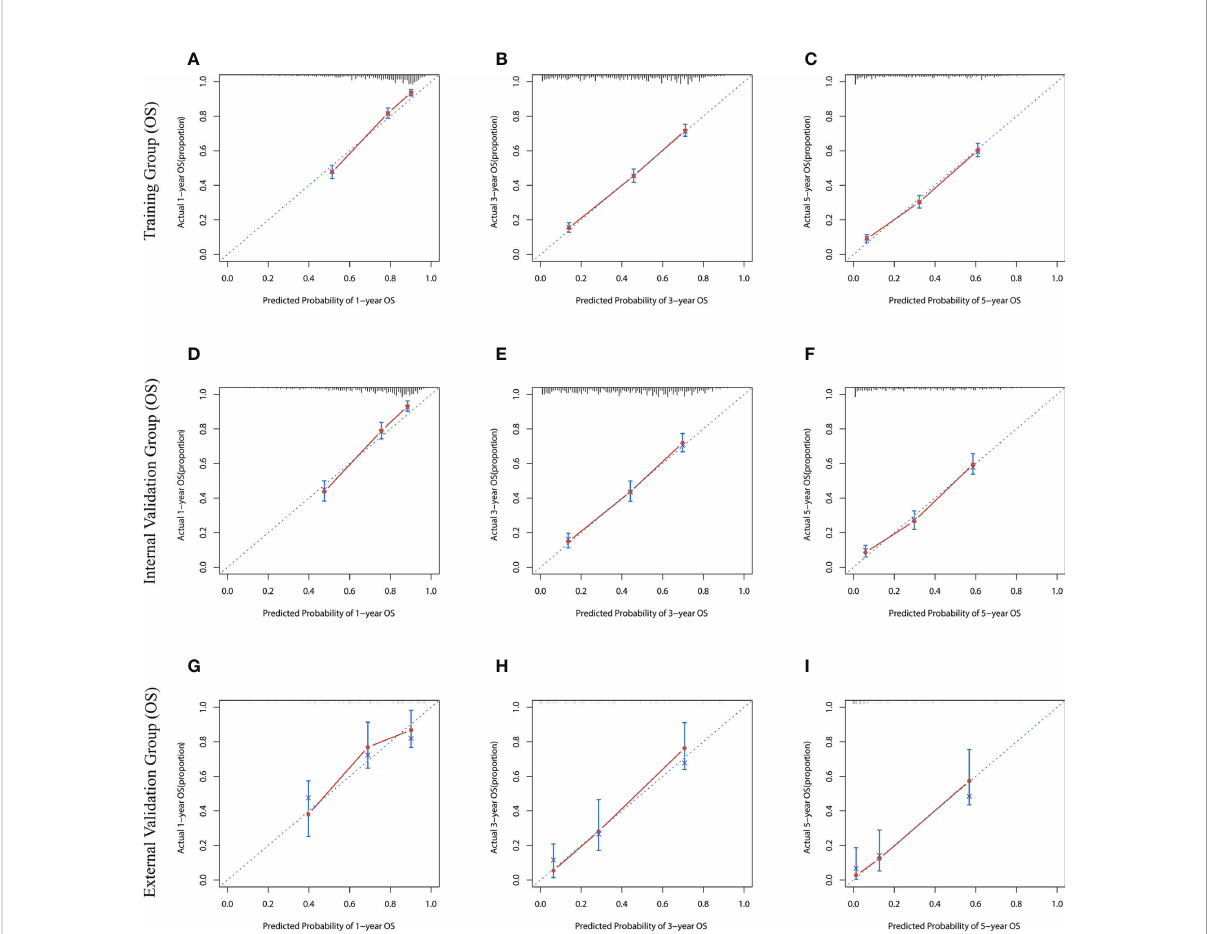
FIGURE 3 The calibration curves for predicting OS at (A) 1-year and (B) 3-year and (C) 5-year in the training cohort, and at (D) 1-year (E) 3-year and (F) 5- year in the internal validation cohort, and at (G) 1-year (H) 3-year and (I) 5-year in the external validation